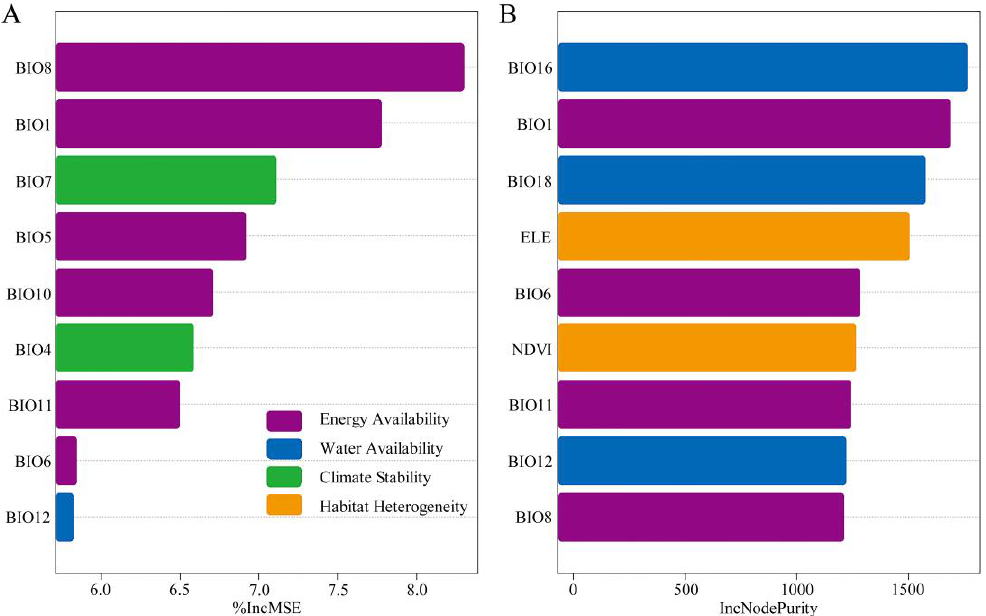
Figure 5. The importance of variables for species richness based on the random forest model by using ( A ) %IncMSE and ( B ) IncNodePurity. ( A ) %IncMSE and ( B )